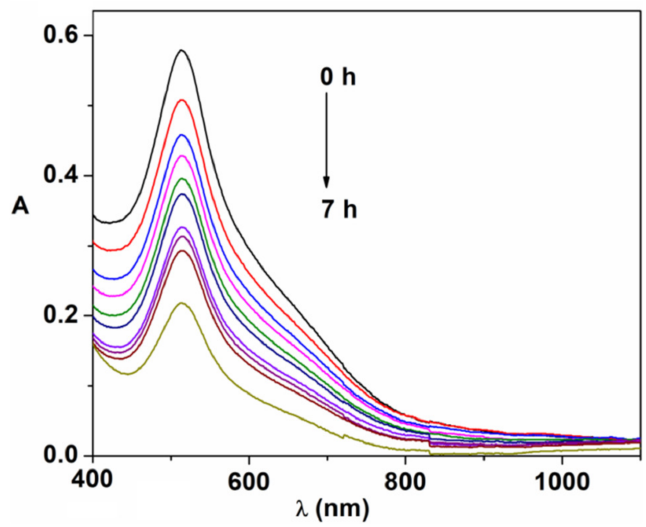
Figure 13. UV − Vis response of DPPH as a function of contact time with cerium oxide